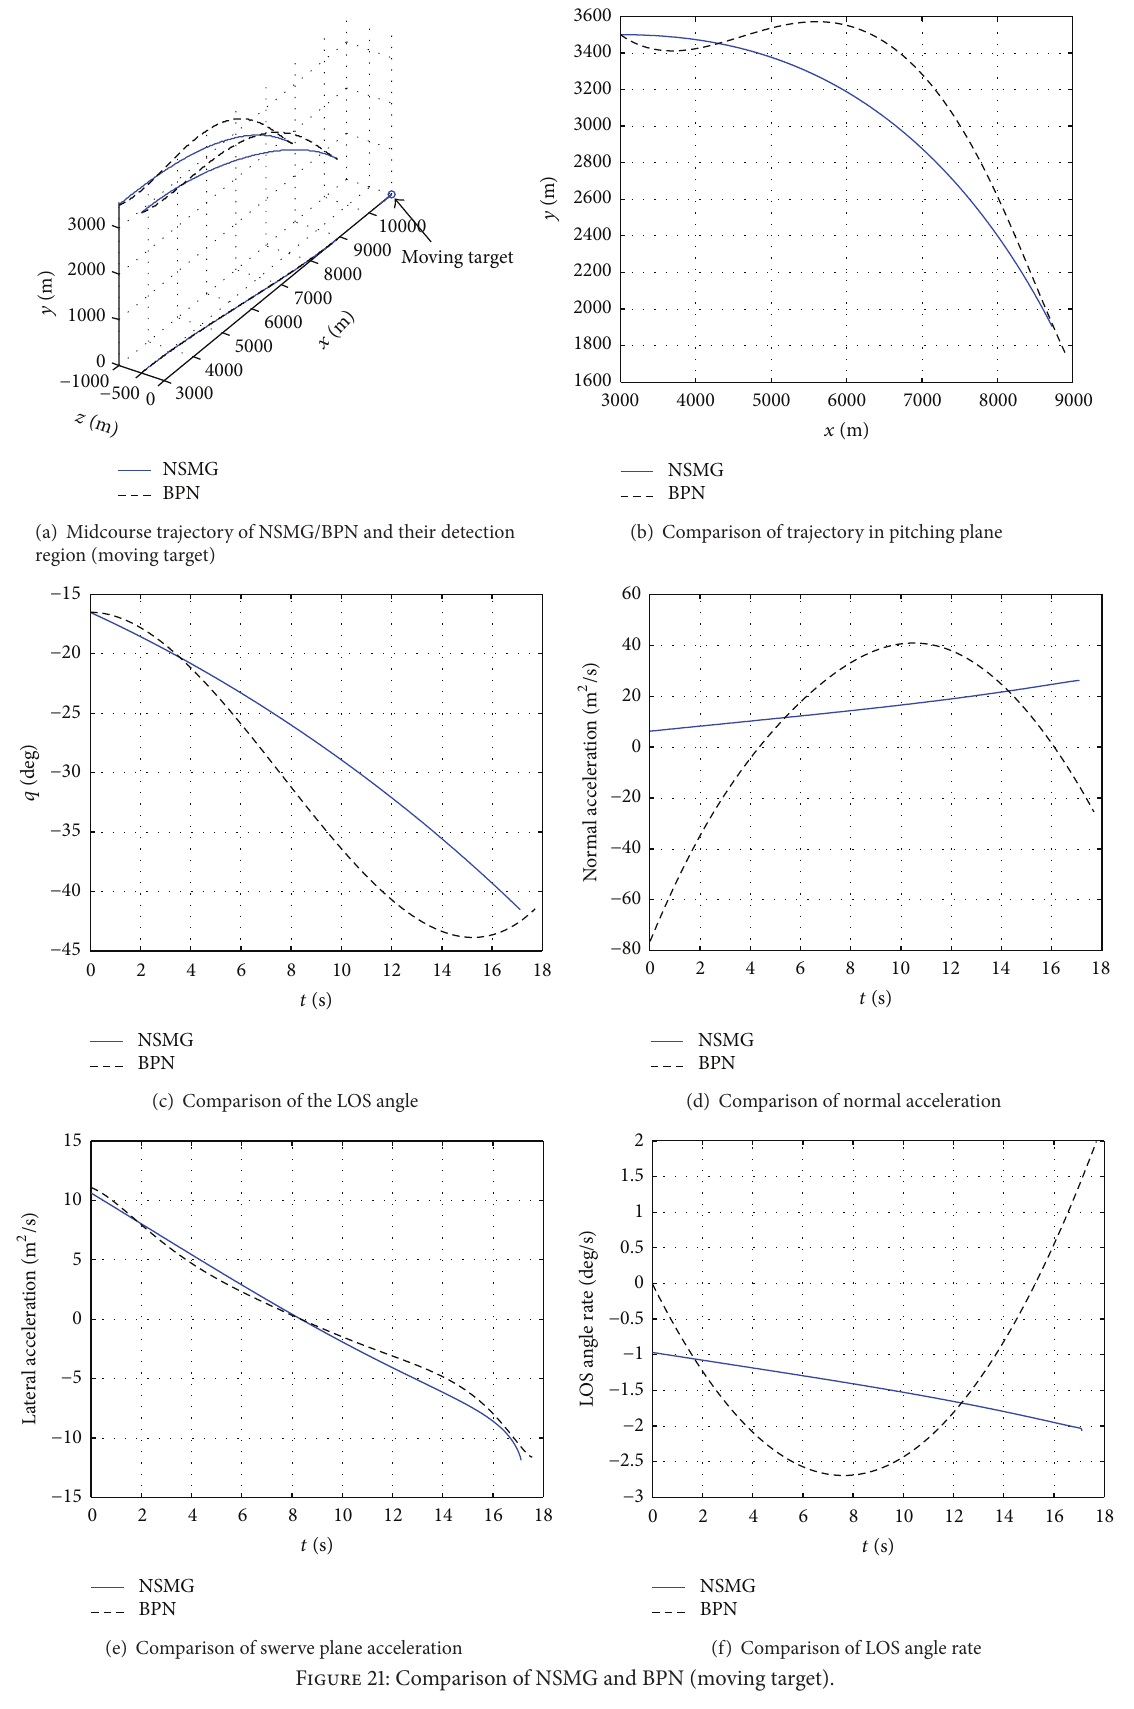
Figure 21: Comparison of NSMG and BPN (moving